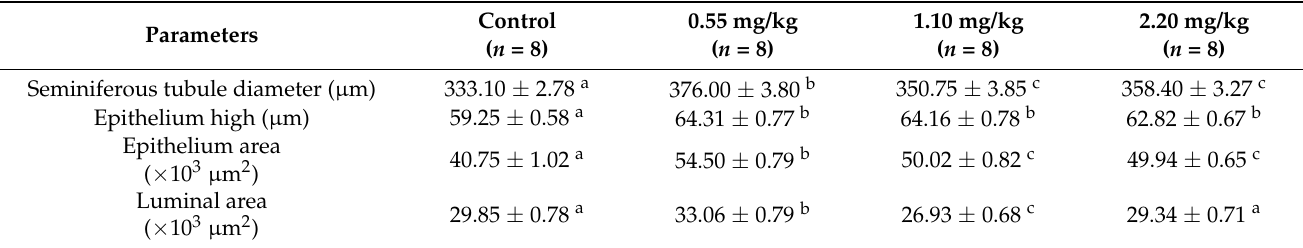
Table 6. Seminiferous tubule diameter, epithelium high, epithelium area, and luminal area at stage VII-VIII of male rats administered with different doses of M. oleifera leaf tea for 30 days.